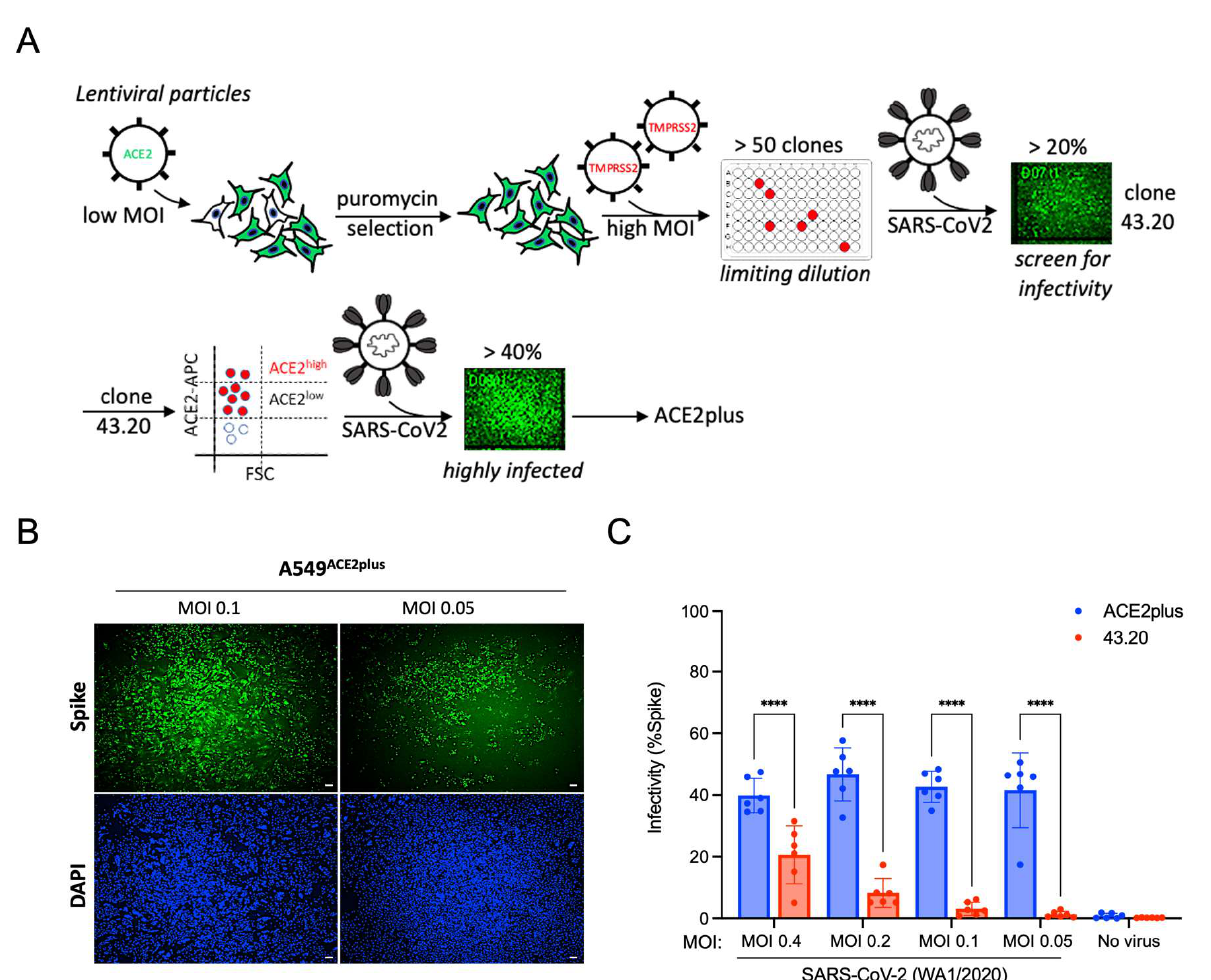
Figure 1A. Following limiting-dilution cloning, over 50 clones were selected and challenged with SARS-CoV-2 USA-WA1/2020 (referred to as “wild type”, WT). Of the 50+ clones, clone 43.20 exhibited the most efficient SARS-CoV-2 infection rate, which was further enriched by cell sorting with an ACE2-targeting antibody as described in Materials and Methods. Following another round of puromycin selection (5 µ g/mL), the infectivity significantly increased to ~40% (Figure 1B,C). Next, we compared the infectivity of ACE2plus and Vero E6 cells. Each cell type was challenged with WT SARS-CoV-2 or the mNeonGreen-labeled SARS-CoV-2 strain icSARS-CoV-2mNG (WT-mNG) at MOIs of 0.05 and 0.1 for 48 h (control cells received growth medium alone). The ACE2plus cells exhibited infection rates of ~60%, similar to the infection rate in the Vero E6 cells (~70%) (Figure S1A). The two lines showed similar viral nucleoprotein transcript levels in the supernatants (Figure S1B).